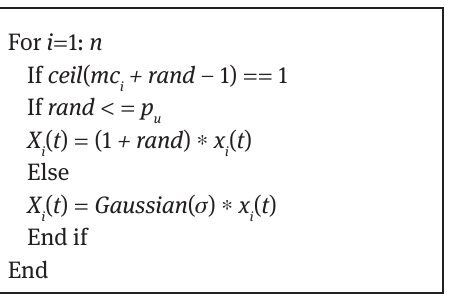
Algorithm 2. Choose the Mutation Model. Algorithm 3. Local